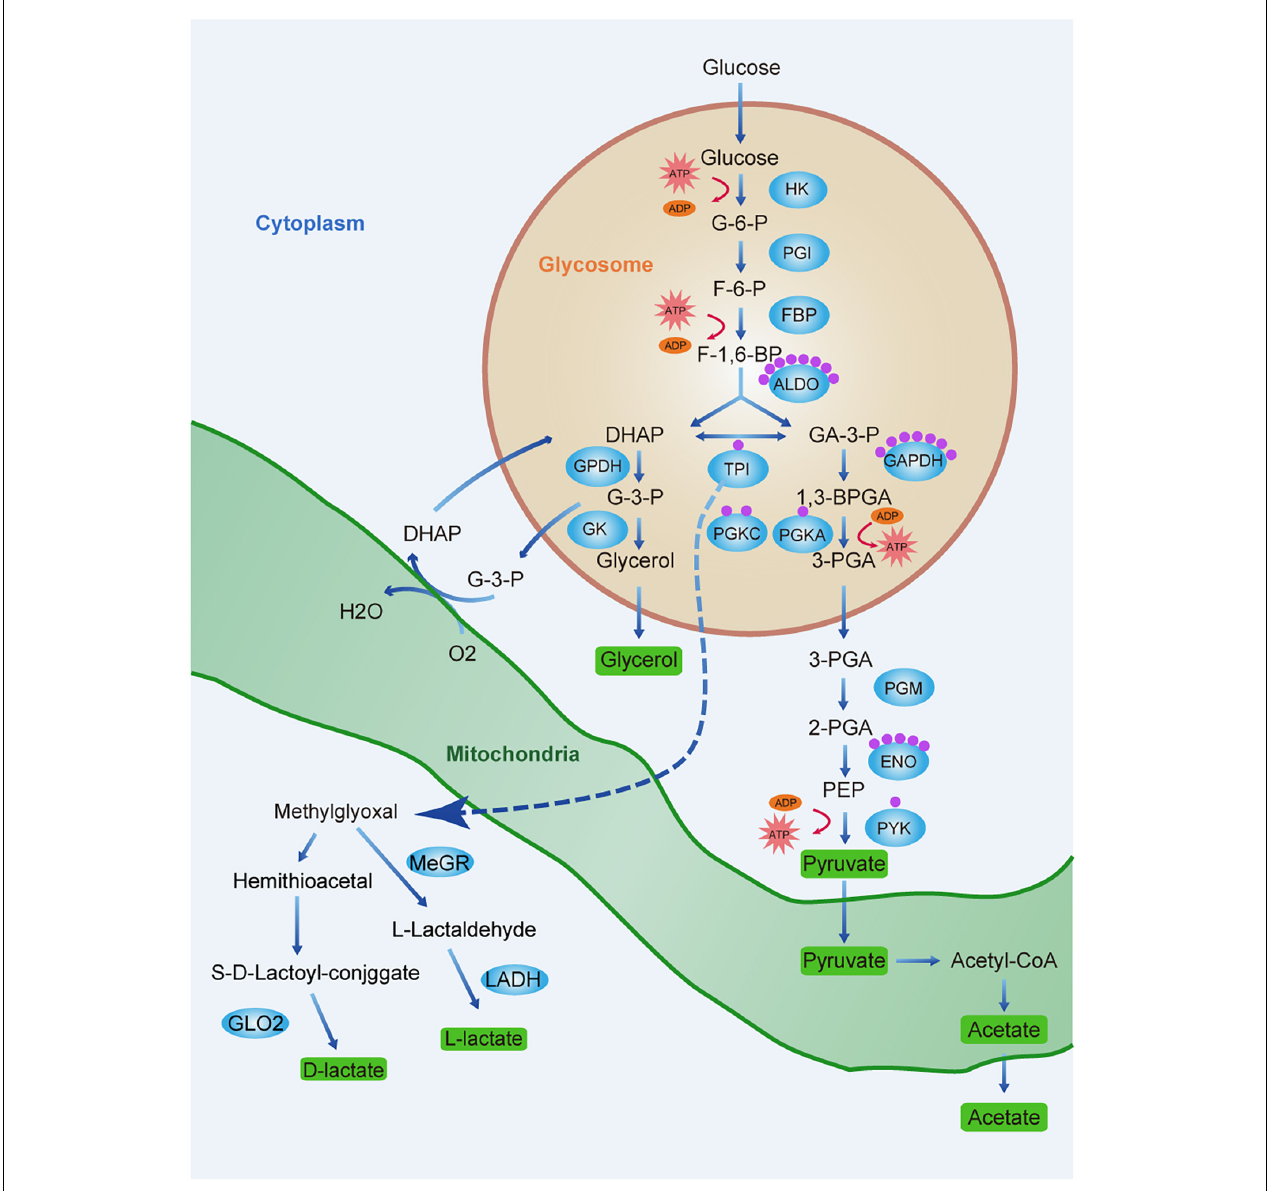
FIGURE 7 | Lactate production and lactylation in the glycolysis of T. brucei . Schematic diagram of the glycolytic pathway and lactate production pathway in T. brucei . Glycerol 3-phosphate (G3P) is re-oxidized by mitochondrial glycerol phosphate complex and returned to the glycosome for further cycling. Green rectangles represent end-products which must be excreted by parasite to maintain homeostasis and ensure survival. Blue ellipses represent enzymes of the metabolic pathways. Each purple sphere represents a lactylated site on the protein. Abbreviations: G-6-P, glucose 6-phosphate; F-6-P, fructose 6-phosphate; F-1,6-BP, fructose 1,6-bisphosphate; DHAP, dihydroxyacetone phosphate; GA-3-P, glyceraldehyde 3-phosphate; G-3-P, glycerol-3-phosphate; 1,3-BPGA, 1,3-bisphosphoglycerate; 3-PGA, 3-phosphoglycerate; 2-PGA, 2-phosphoglycerate; PEP, phosphoenolpyruvate; HK, hexokinase; PGI, glucose phosphate isomerase; PFK, phosphofructokinase; TPI, triosephosphate isomerase; GPDH, glycerol-3-phosphate dehydrogenase; GK, glycerol kinase; GAPDH, glyceraldehyde-3-phosphate dehydrogenase; PGK, phosphoglycerate kinase; PGM, phosphoglycerate mutase; PYK, pyruvate kinase; G6PDH, glucose-6-phosphate dehydrogenase; MeGR, methylglyoxal reductase; LADH, lactaldehyde dehydrogenase; and GLO2, glyoxalase